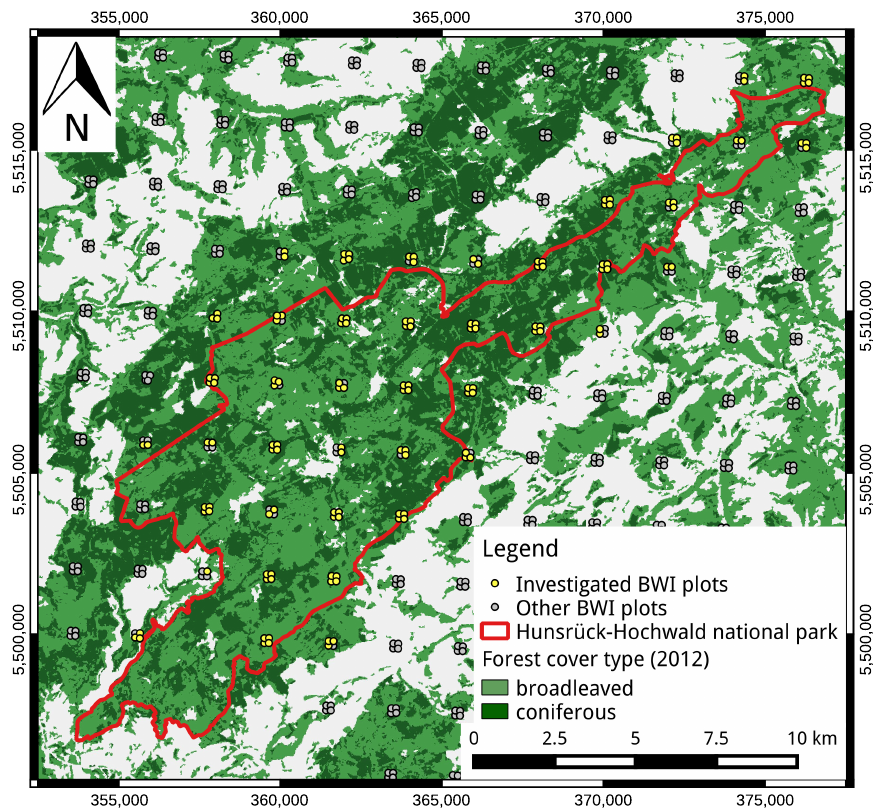
Figure 1. Study area and German National Forest Inventory ( Bundeswaldinventur , BWI) sampling design. Background: Web Map Service (WMS) of forest types provided by Copernicus [35].